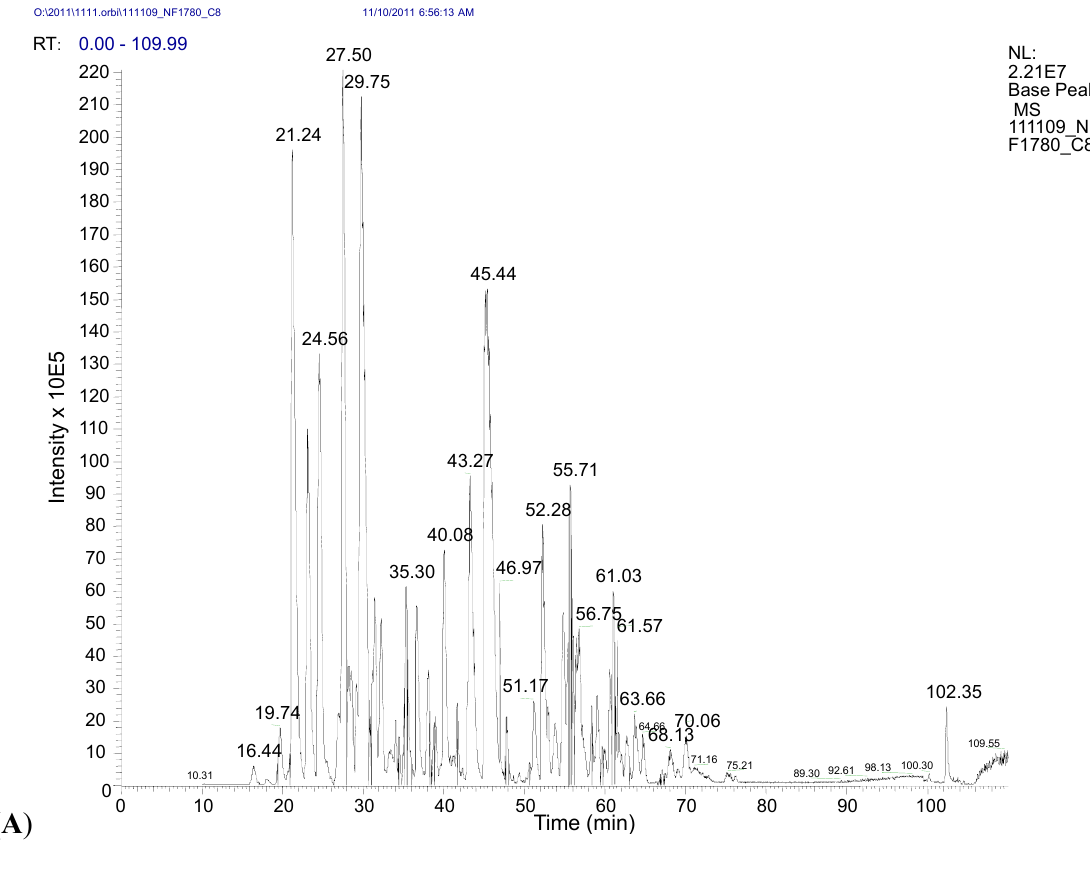
Figure 3. Quantification of the DISC. ( A – C ) Workflow for the quantification as exemplified for caspase-8. ( A ) Base peak chromatogram of the mass spectrometric analysis of gel slice 8. A two hour gradient was applied. ( B ) Extracted ion chromatograms of the endogenous light and spiked-in heavy peptide NLYDIGEQLDSEDLASLK (A light and A heavy) and endogenous light and spiked-in heavy peptide FLSLDYIPQR. (B light and B heavy). RT: retention time; MA: marked area (AUC). The ratios of light and heavy areas are calculated and used for quantification of the light peptides. ( C ) Database search of MS2 data confirmed the sequence of the two light and heavy peptide pairs of procaspase-8. ( D ) Extracted ion chromatograms of corresponding peptide pairs for FADD in gel slice 13. A1 heavy/light and A2 heavy/light represent the same peptide sequence in two different charge states, 2+ and 3+, respectively, with the same retention time of 46 min. The second (B heavy/light) and third peptide (C heavy/light) are more hydrophilic and elute earlier from the reverse phase column. ( E ) Stoichiometry of the CD95 DISC. Total amounts of proteins were calculated from the extracted ion chromatograms and normalized to FADD. The stoichiometry was determined to be 1:2:0.1:0.3 for FADD, procaspase-8, c-FLIP and